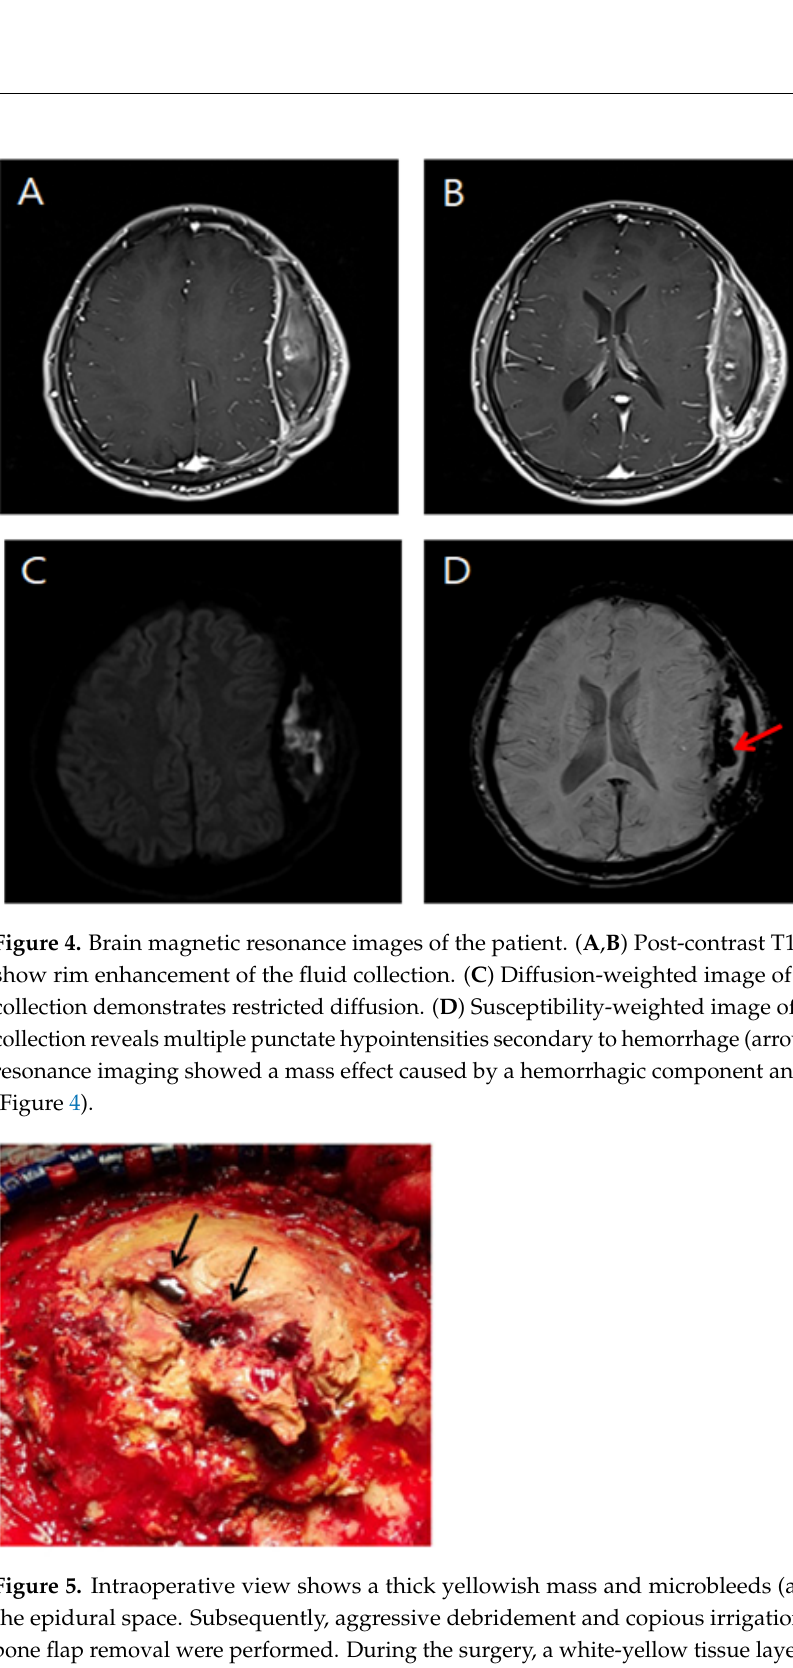
3 of 4 Figure 3. Brain contrast-enhanced computed tomography images show erosion of the bone flap and rim enhancement of the fluid collection. Physical examination did not reveal any tenderness, swell- ing, or wound dehiscence at the time of admission to the ER. However, squeezing of the left tem- poral incision site of the previous cranioplasty surgery caused the release of a small amount of pu- rulent discharge. On neurological examination, the patient had a clear mental status and no neuro-